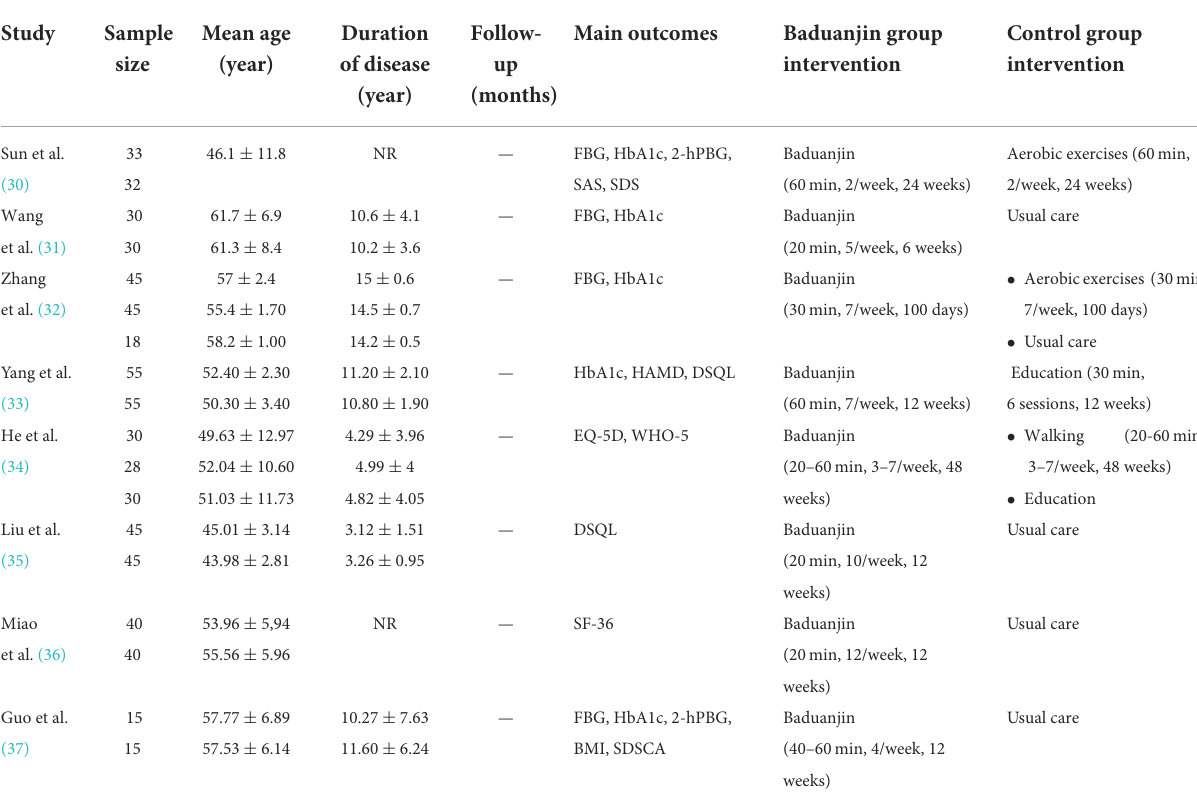
Figure 4C) compared with other exercises. Sensitivity analyses yielded similar and non-significant differences for the above- mentioned outcomes. Figure 6. The publication bias was small because the spots were substantially symmetric.